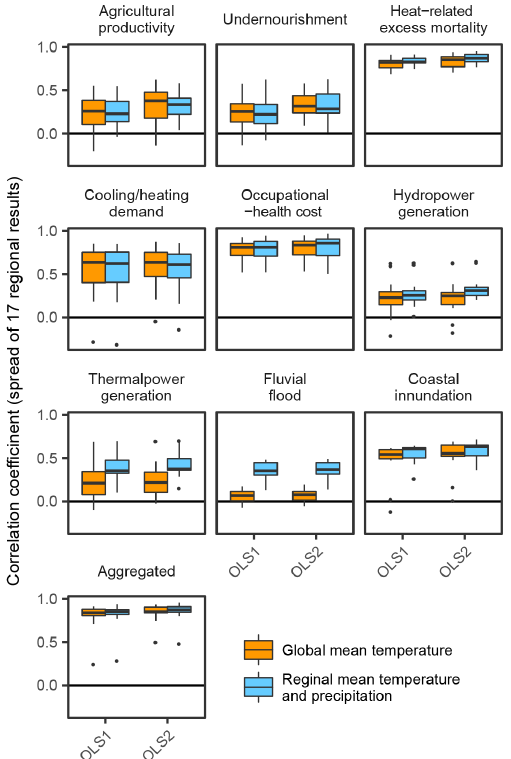
Figure 2. Performance of emulations in comparison 1. Correlation coefficients between simulation results and emulation results are shown. Bars and edges of boxes represent medians and first/third- quantile values among 17 regional results. The ends of the whiskers show the minimum and maximum values, while outliers are denoted by dots if they